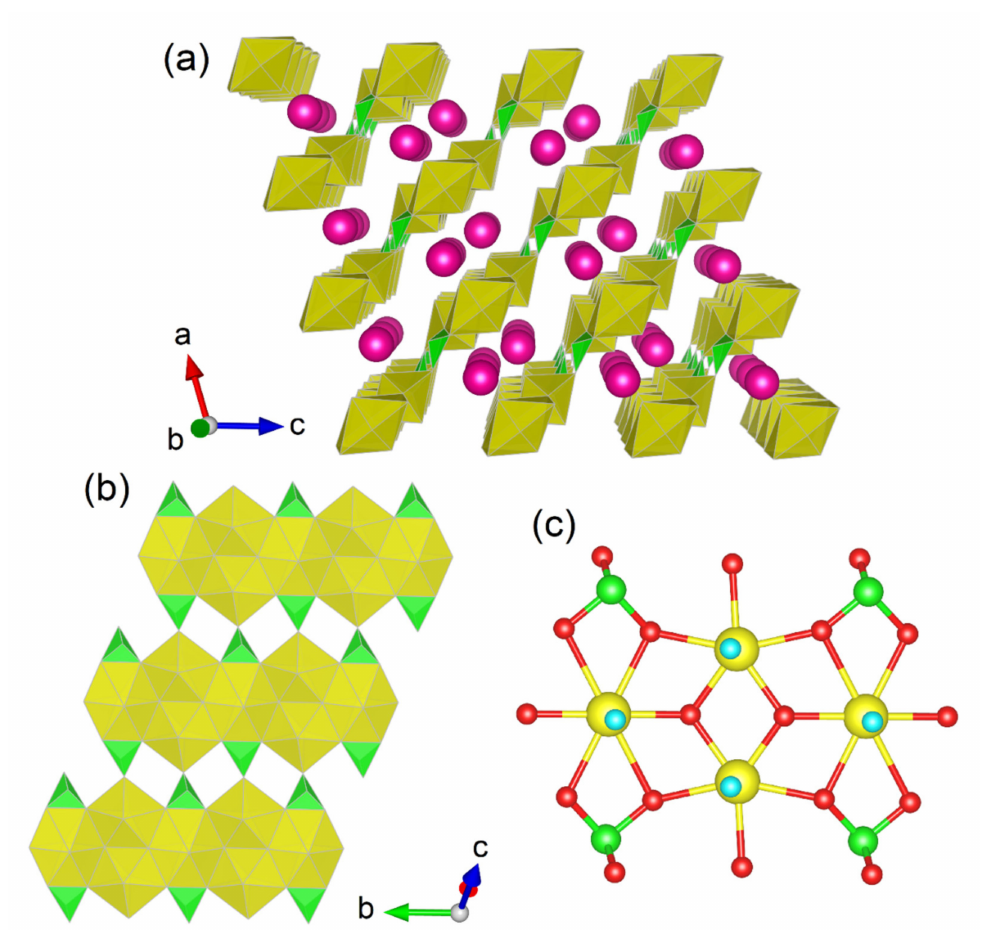
Figure 2. Structural representation of triclinic Rb 2 [(UO 2 ) 3 (SeO 3 ) 2 O 2 ] in space group P1 ( a ) general representation, ( b ) illustrating the layer configuration of the structure and ( c ) highlighting the coordination motif of UO 7 and SeO 3 units. Note yellow polyhedra, green polyhedra, green spheres, yellow spheres, red spheres and blue spheres respectively represent UO 7 , SeO 3 , Se, U, O and uranyl O units/atoms